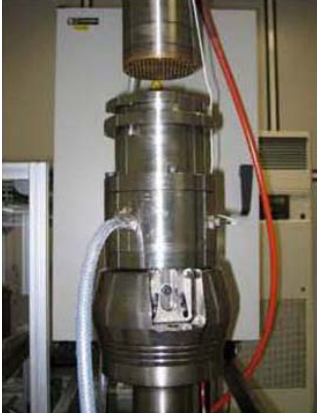
Fig 8: Experimental setup for compression test